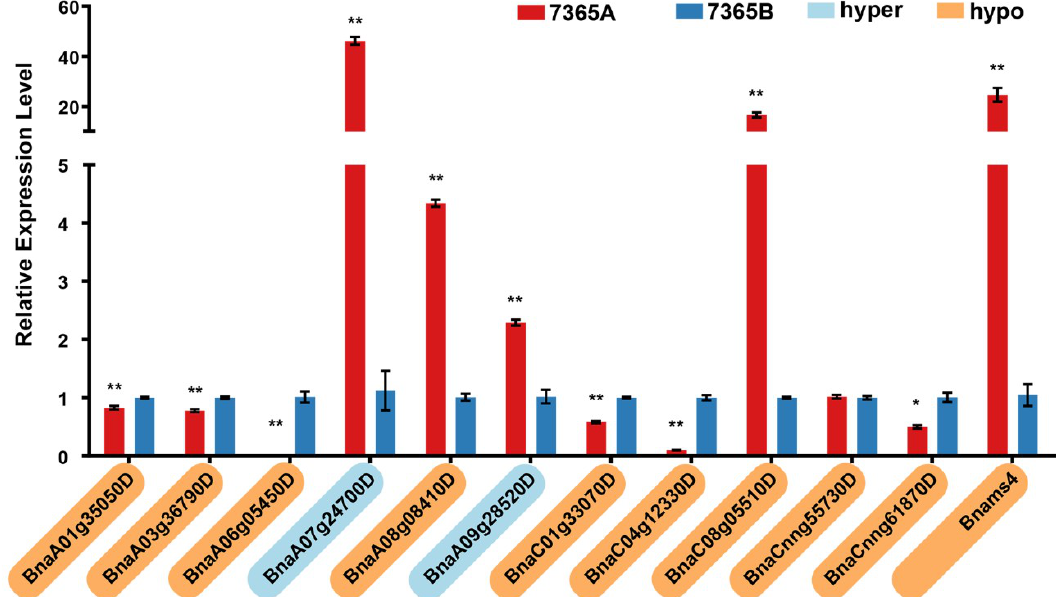
Figure 8. Expression analysis of pollen development-related DMGs and Bnams4 . The asterisk indicates a significant difference between 7365A and 7365B (*: p -value < 0.05, **: p -value < 0.01). The Gene ID highlighted in yellow and blue on the vertical axis represents hyper-methylated and hypo-methylated DMRs.